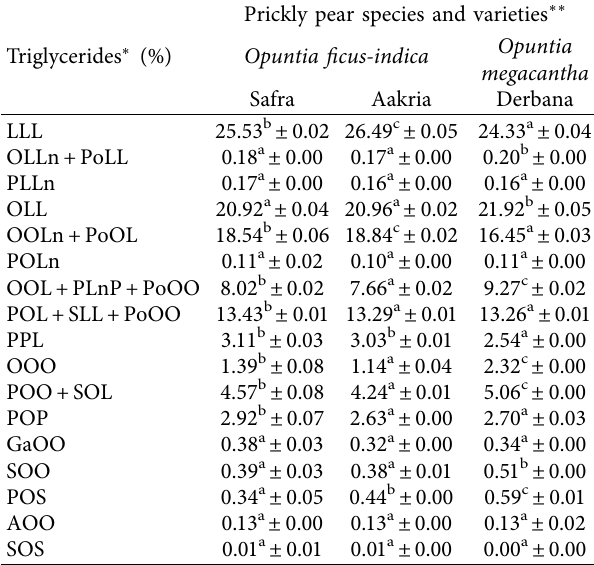
Table 3: Triglyceride composition of seed oils of two prickly pear species: Opuntia ficus-indica (“Safra” and “Aakria” varieties) and Opuntia megacantha (“Derbana” variety). Triglycerides ∗